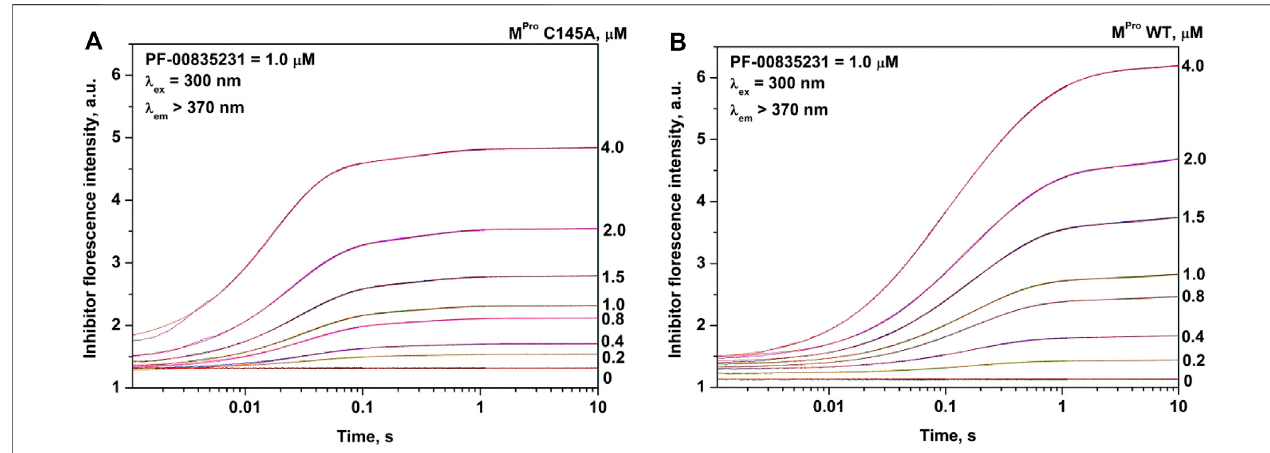
FIGURE 5 | Experimental and theoretical (red) kinetic curves of changes in PF-00835231 fl uorescence intensity during the interaction with C145A M pro (A) or WT M pro (B) .TheconcentrationofPF-00835231was1.0 µM,andtheenzymeconcentrationisshowninthepanel.Substantialoverlapofexperimentalandtheoreticalkinetic curves indicates good fi tting quality and masks visual differences between experimental and theoretical traces.